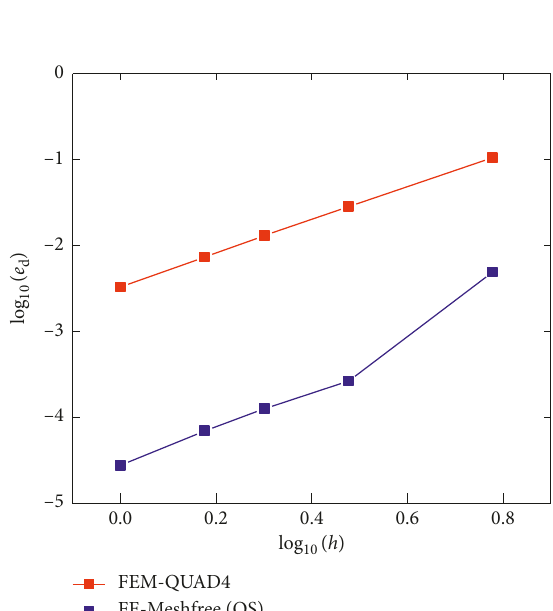
Figure 7: Strain energy convergence.